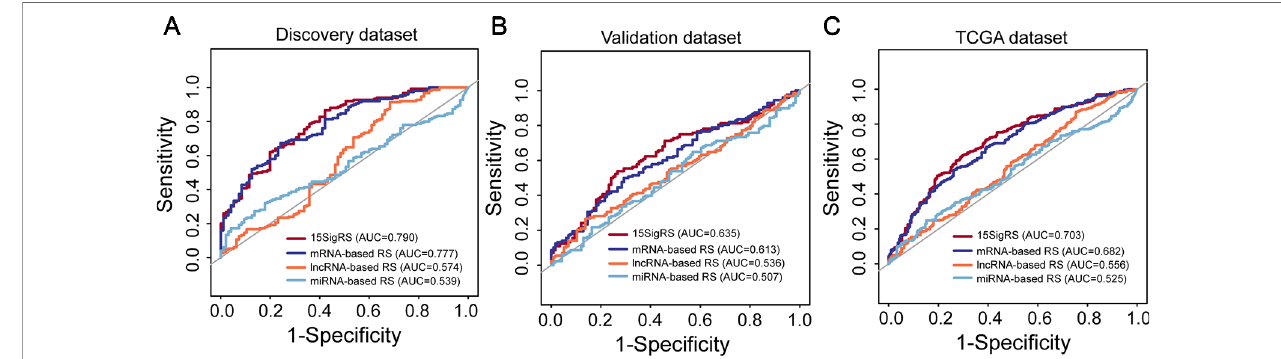
FIGURE 6 | ROC analysis of the 15SigRS with the single RNA type-based signatures in the discovery data set (A) , validation data set (B) , and TCGA data set (C) .